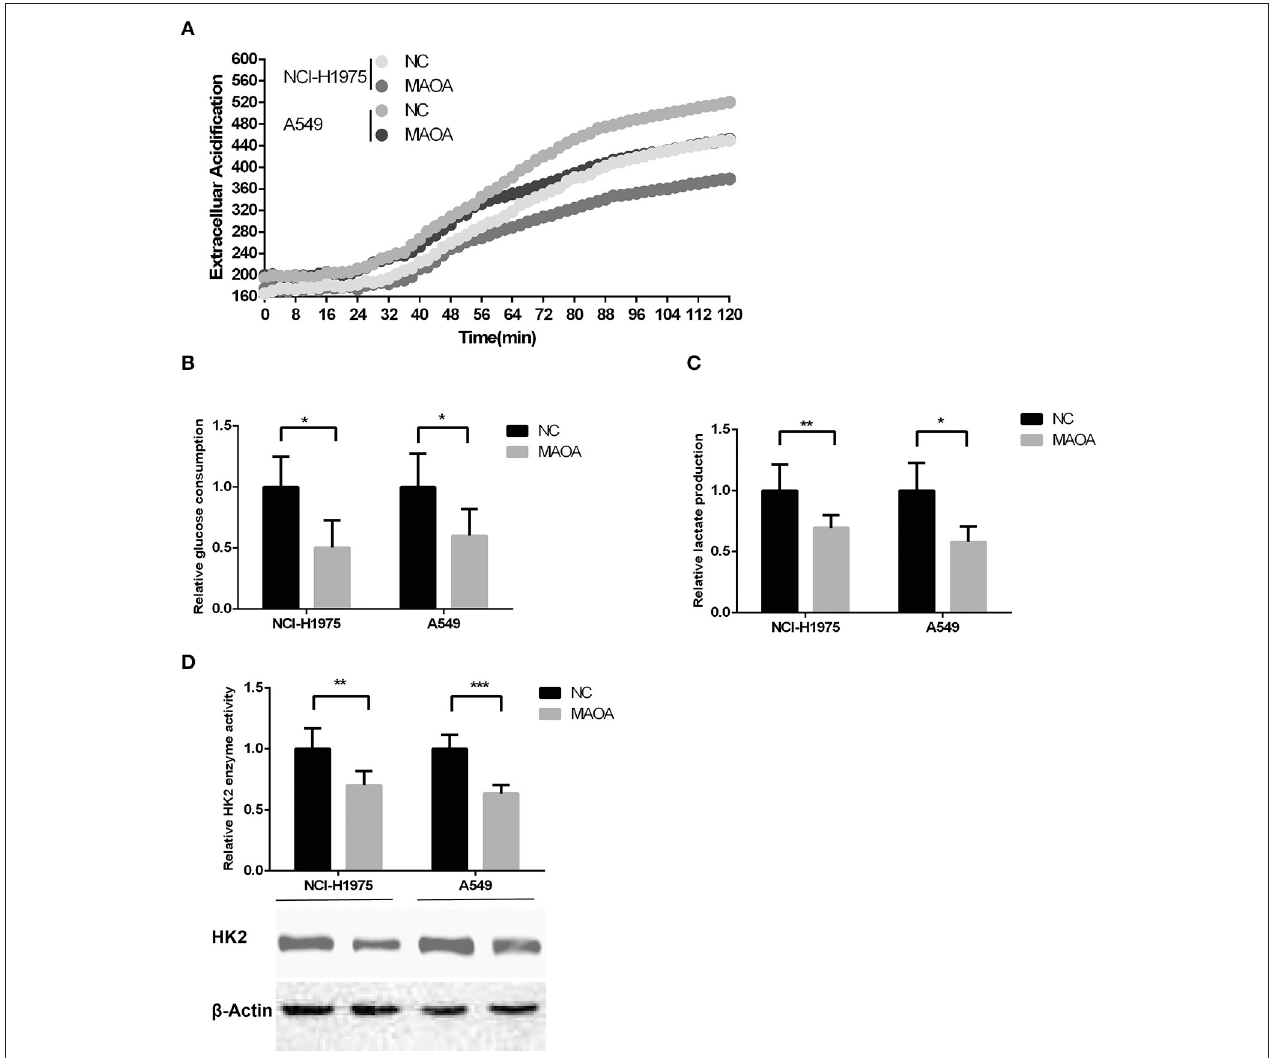
FIGURE 4 | Aerobic glycolysis in MAOA-overexpressing LUAD cells. (A) Extracellular acidification rate [ECAR, (B) glucose consumption, and (C) lactate production were analyzed in MAOA-overexpressing and control LUAD cells. (D) The enzymatic activity and protein level of hexokinase 2 (HK2)] were detected by hexokinase activity assay and Western blot, respectively. Data are presented as mean + SD ( n = 3). * p < 0.05, ** p < 0.01, and *** p < 0.001, compared to the control